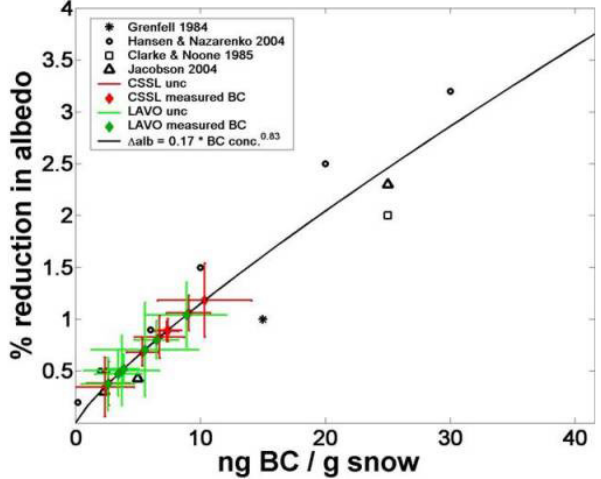
Fig. 2. Model results for BC induced albedo reduction on snow and subsequent potential for measured BC concentrations in falling snow at LAVO and CSSL to reduce snow surface